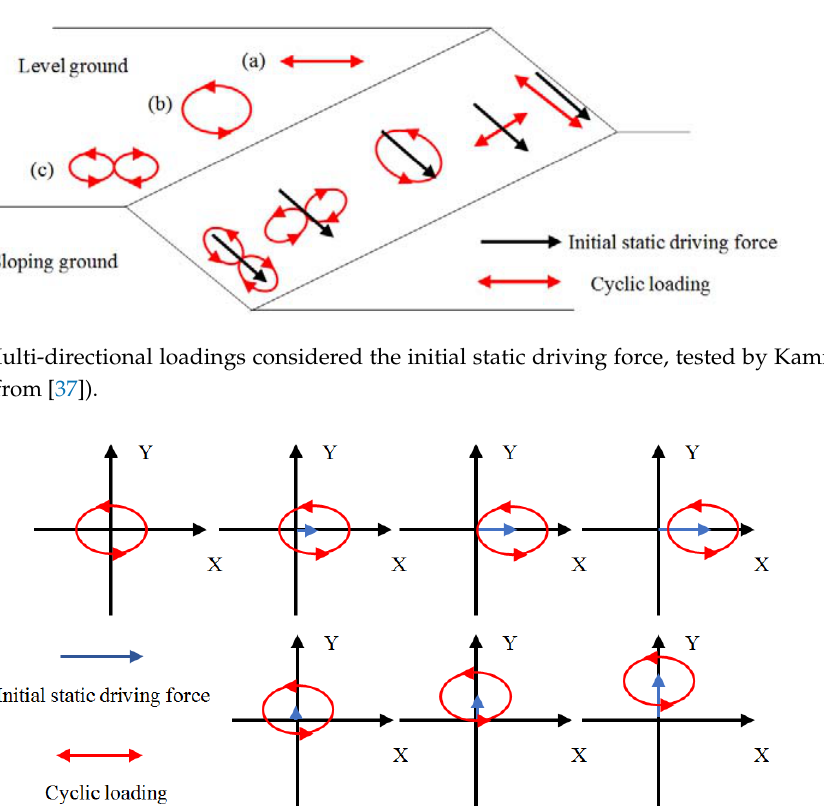
Figure 8. Different levels of stress reversals in tests with varied stress paths, by Kammerer (Reprinted from [37]).